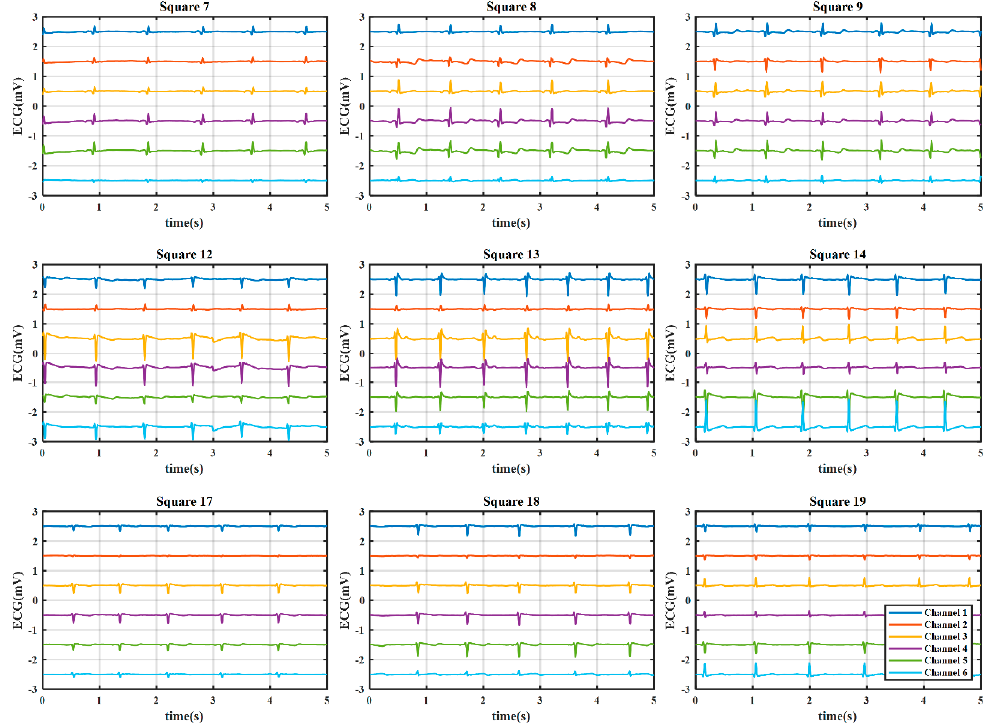
Figure 15. The typical six-channel ECG signals of the fine-grained squares on the human body. The offset between the adjacent channels was 1 mV, and the vertical ordinate only indicated the relative value.